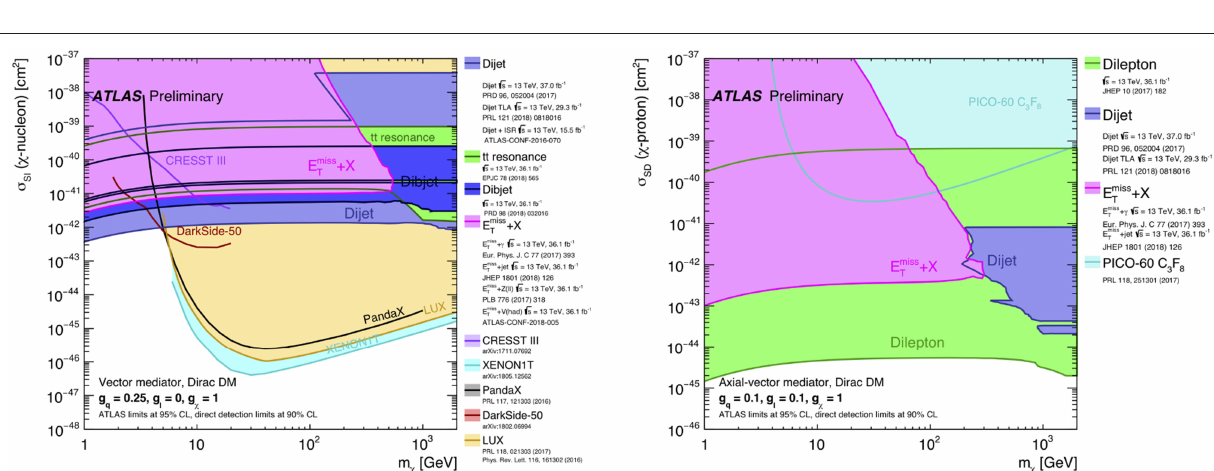
FIGURE 5 | A comparison of the inferred limits to the constraints from direct detection experiments on the spin-dependent WIMP-proton scattering cross-section in the context of the vector leptophobic model (Left) and on the spin-independent WIMP-nucleon scattering cross-section in the context of the axial-vector leptophilic model (Right). The ATLAS results are compared with limits from direct detection experiments. ATLAS limits are shown at 95% CL and direct detection limits at 90% CL. ATLAS searches and direct detection experiments exclude the shaded areas. Exclusions beyond the canvas are not implied for the ATLAS results. The dijet and mono-X exclusion regions represent the union of exclusions from all analyses of that